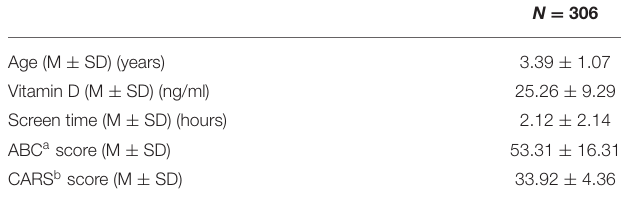
TABLE 1 | Patient characteristics. TABLE 2 | Comparison of vitamin D in each group (grouped by gender, BMI, time of outdoor activities and blood collection month).